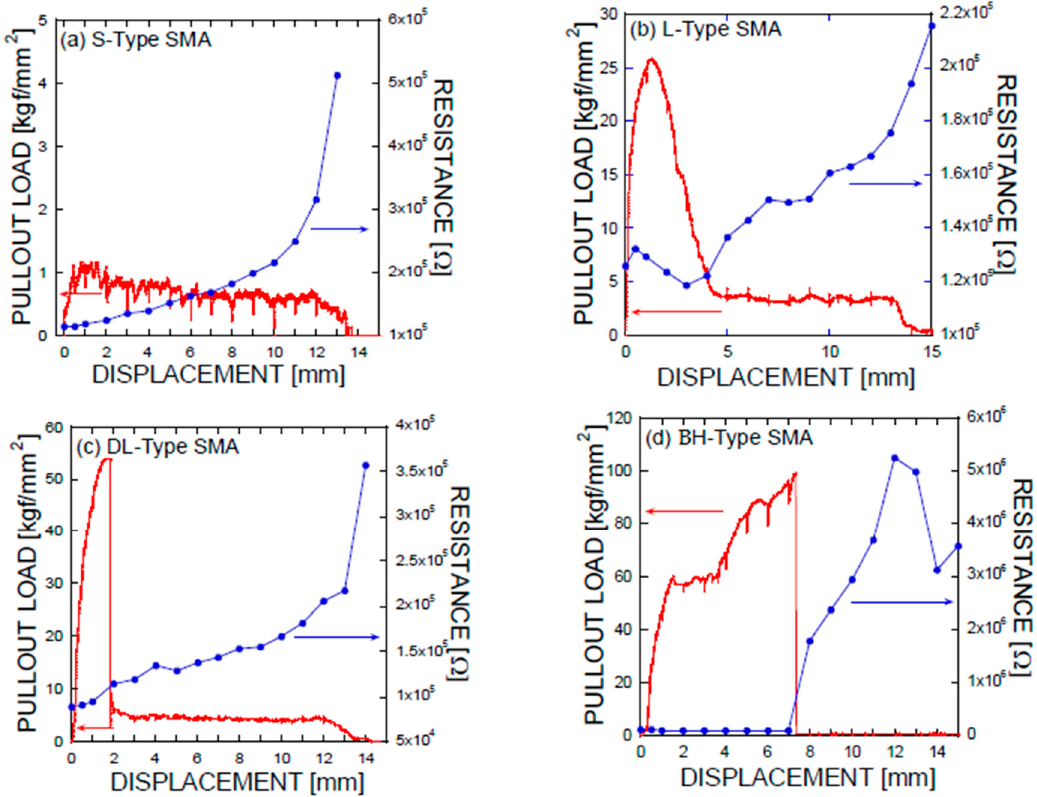
Figure 9. Simultaneous plot of electrical resistance and mechanical load obtained as a function of mechanical displacement obtained for ( a ) S-type; ( b ) L-type; ( c ) DL-type; and ( d ) BH-type Ni/Ti SMA fiber pullout tests.